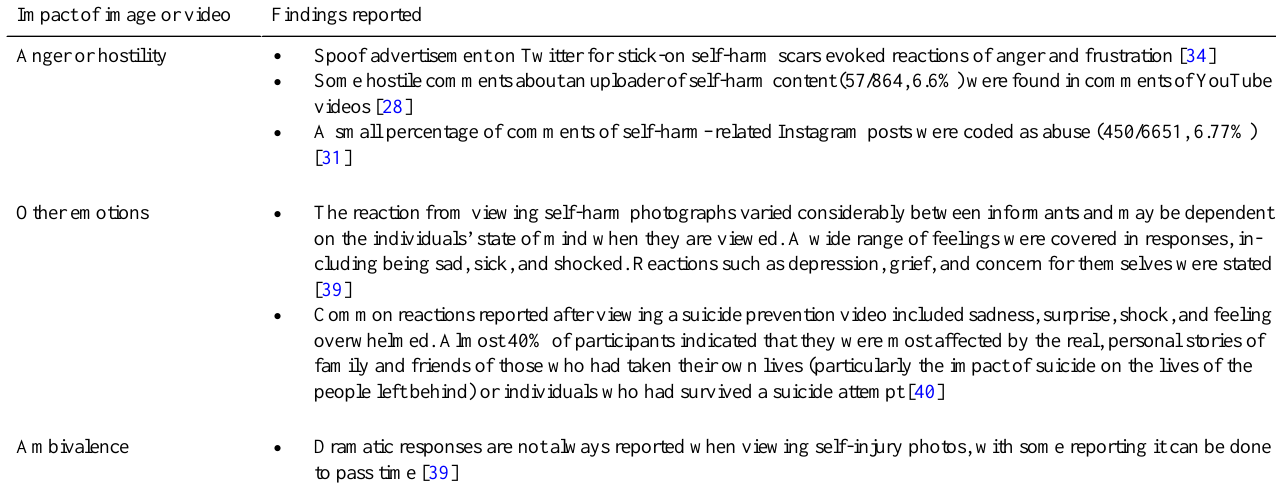
Table 4. Summary of emotional reactions and impacts of viewing and sharing videos and images. Findings reportedImpact of image or